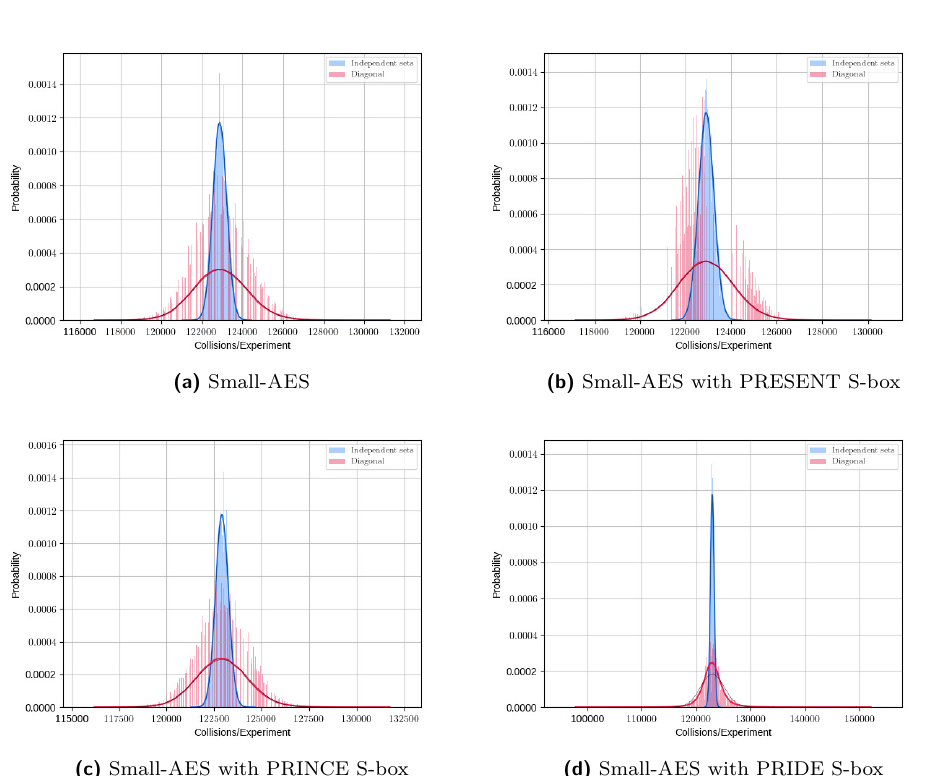
Figure 15: Distribution of the number of collisions in the first cell after four rounds in both settings, with the final MixColumns operation omitted. Both distributions used 100 000 random keys and counted the collisions from 2 14 δ -sets per key that were independent in Setting (1) or the 2 14 δ -sets from D . Thin lines are fitted normal distributions, thick lines the best fitted { 0 }